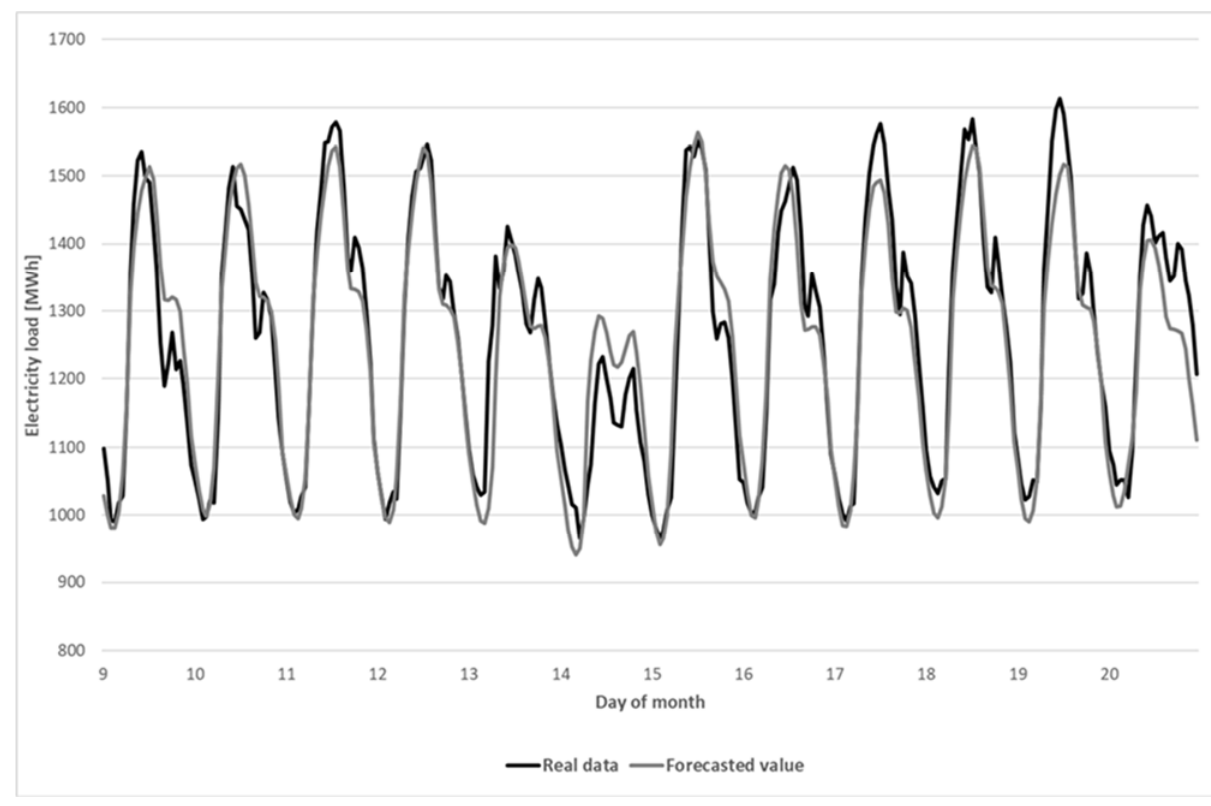
Figure A1. Actual vs predicted electricity load.